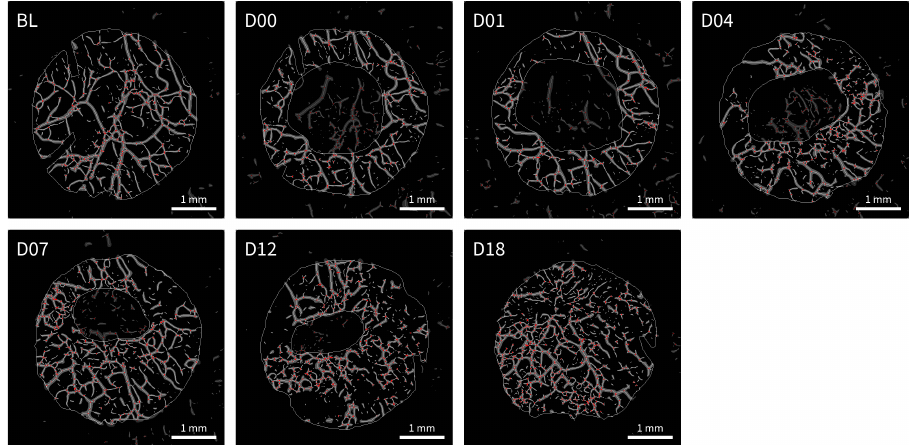
Figure 4. Vascular network derived from OCT angiograms. Graphics depict the OCTA data timeline acquired from the non-diabetic mouse shown in Figure 3a after post-processing. The extracted binary images were used for calculating the four vascular parameters vessel density, normalized vessel length, number of bifurcations per unit length, and vessel tortuosity. The region covered by the donut-shaped ring and the wound site were excluded during evaluation of the vascular parameters and are shown